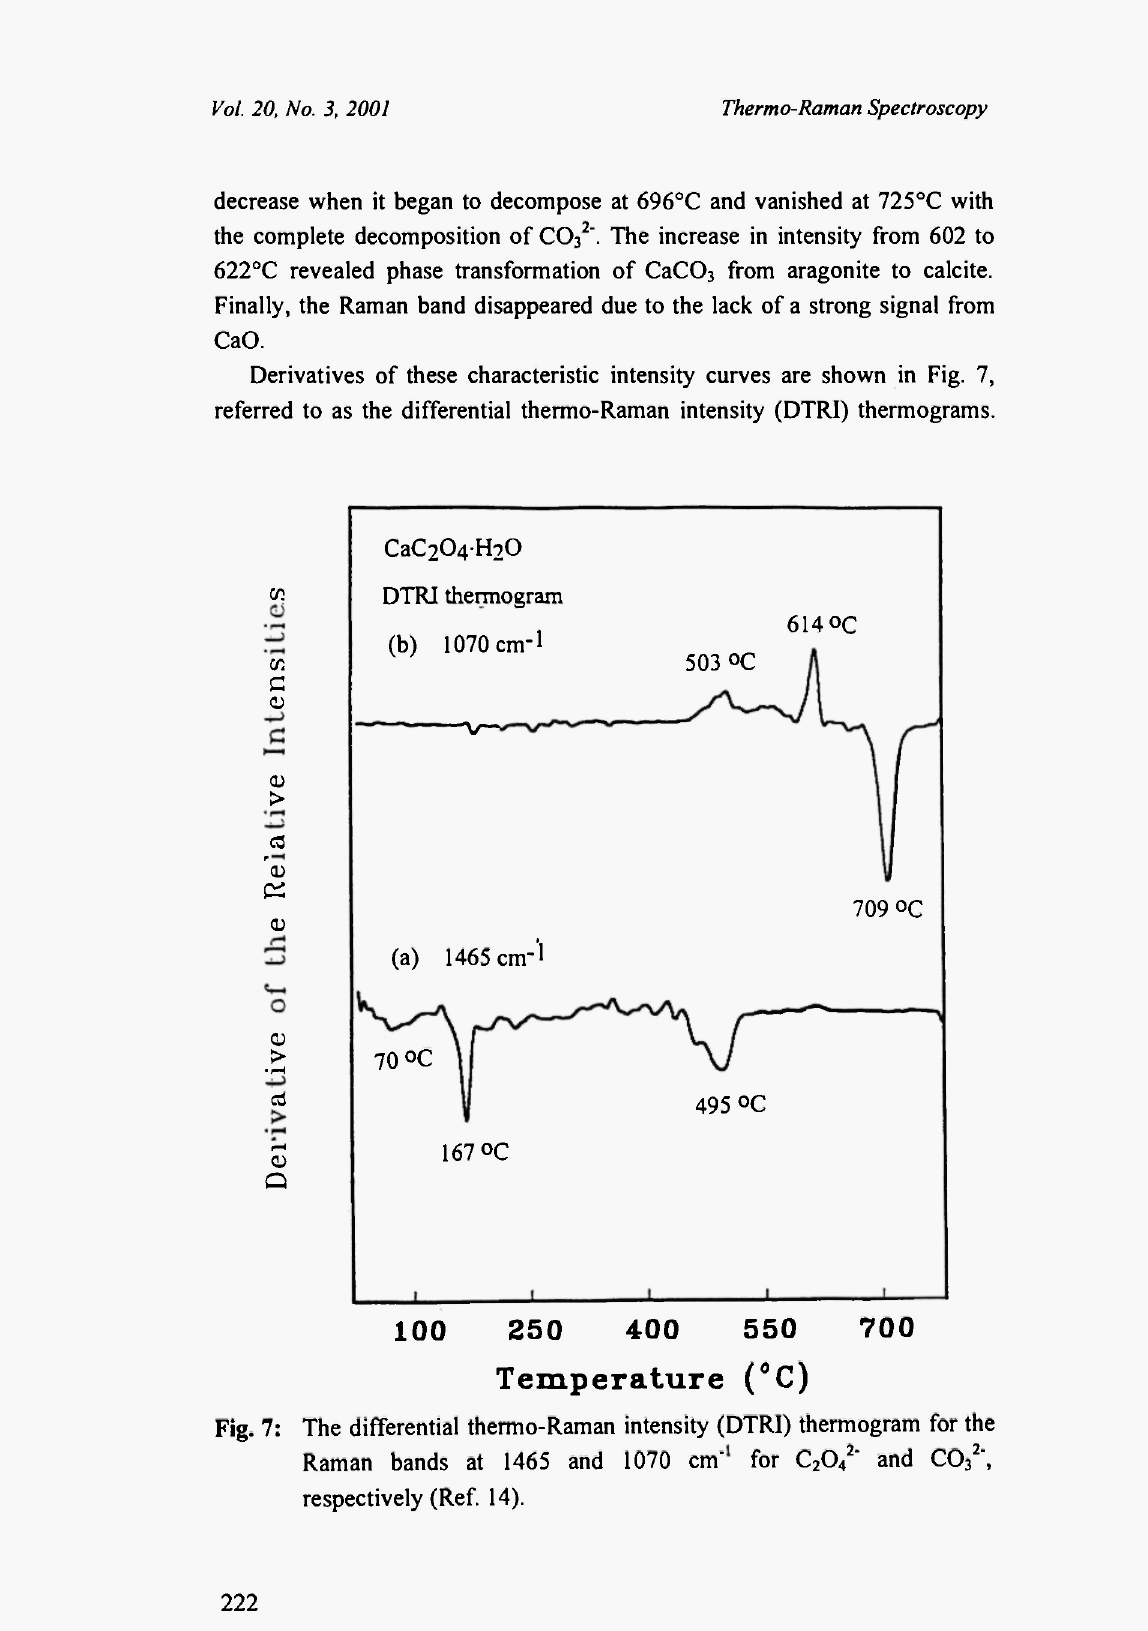
for C 2 0 4 2 " and C0 3 2 ',